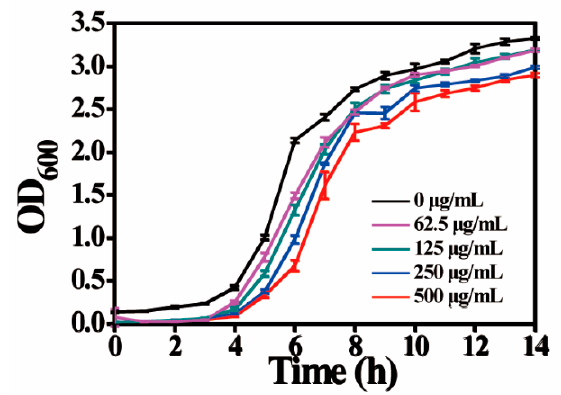
Figure 4. Growth curves of Salmonella cells in lysogeny broth (LB) with various concentrations of MnO 2 nanosheets at 4 °C .